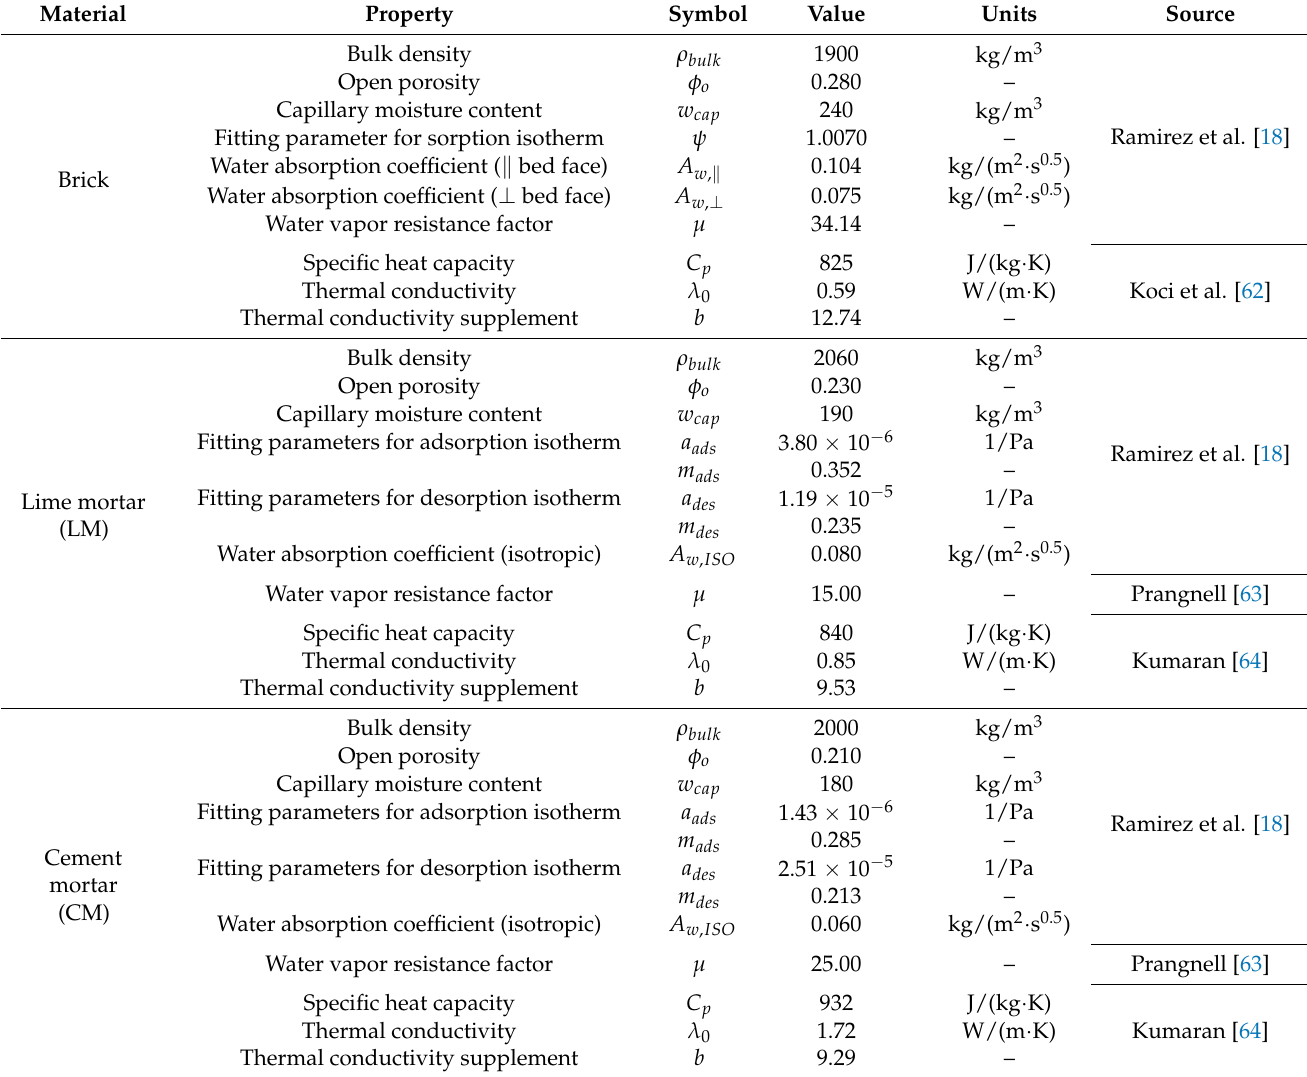
Table 1. Summary of material properties used for the hygro-thermal